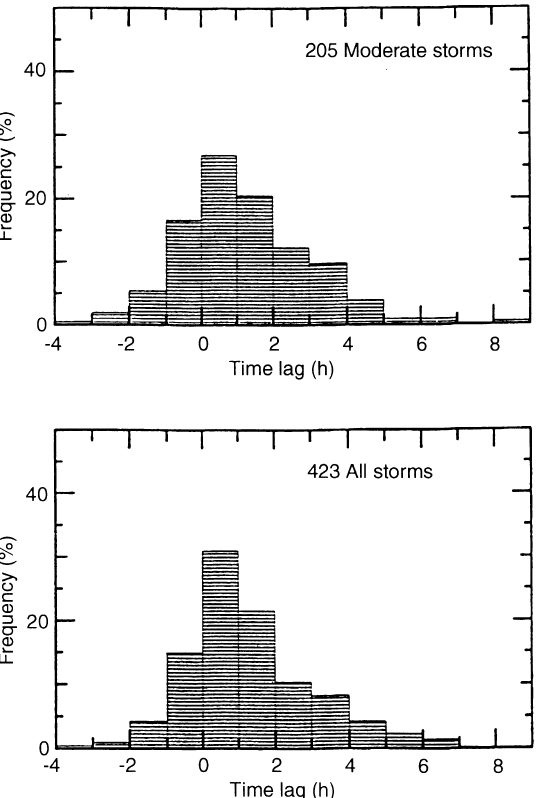
(cid:133)(cid:133)(cid:255) 50 > Dst min (cid:21) (cid:255) 100nT (cid:134) intense storms (cid:133) Dst min < (cid:255) 100nT (cid:134) , and allstorms,where Dst istheminimum Dst .The horizontalaxis showsthe time lag in hours and the vertical axis (the occurrence frequency) is in percentage for